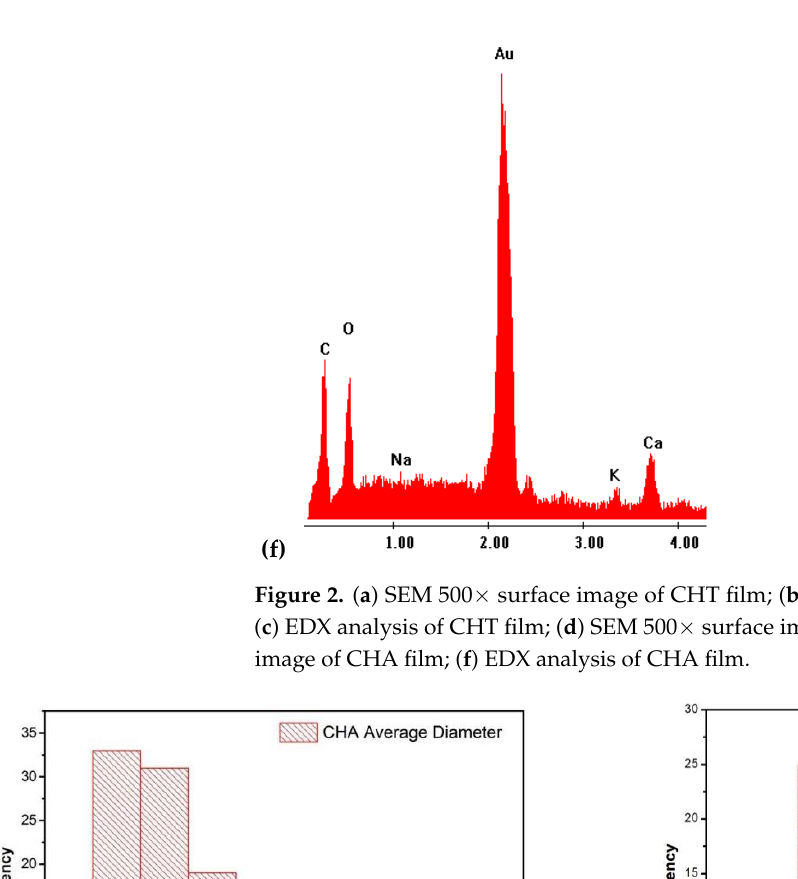
Figure 3. Particle size distribution: ( a ) CHT, and ( b ) CHA film (Programa ImageJ ® ). Frequency: num- ber of particles of the same size that are repeated.